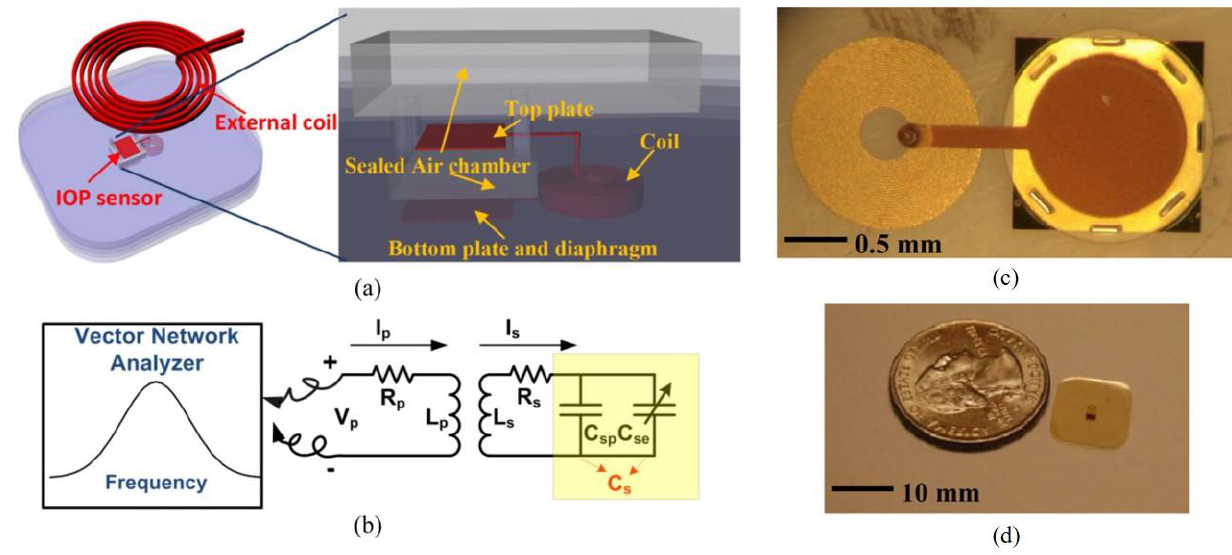
Figure 14. ( a ) Three-dimensional schematic of the wireless IOP sensor system. ( b ) Equivalent circuit of the system. ( c ) Top view of the IOP sensor. ( d ) Size of the IOP sensor compared to a U.S. quarter. © 2012 IEEE. Reprinted from Xue et al. [9] with permission.